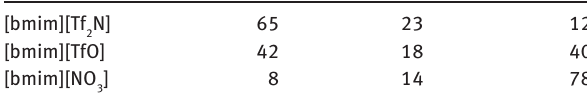
, 1.5 equiv. TBHP, 25 ° C, 2